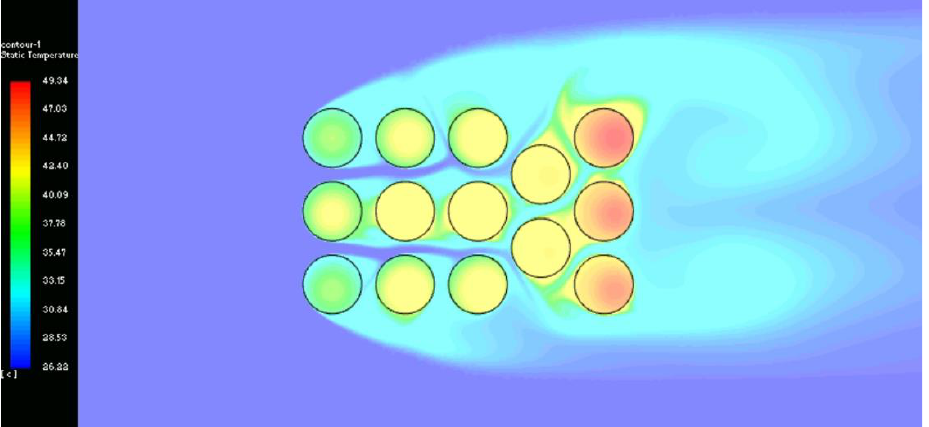
Figure 14. Temperature contours in the middle longitudinal plane.